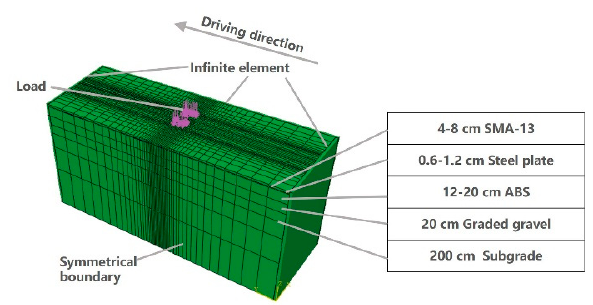
Figure 3. ASP pavement finite element model.